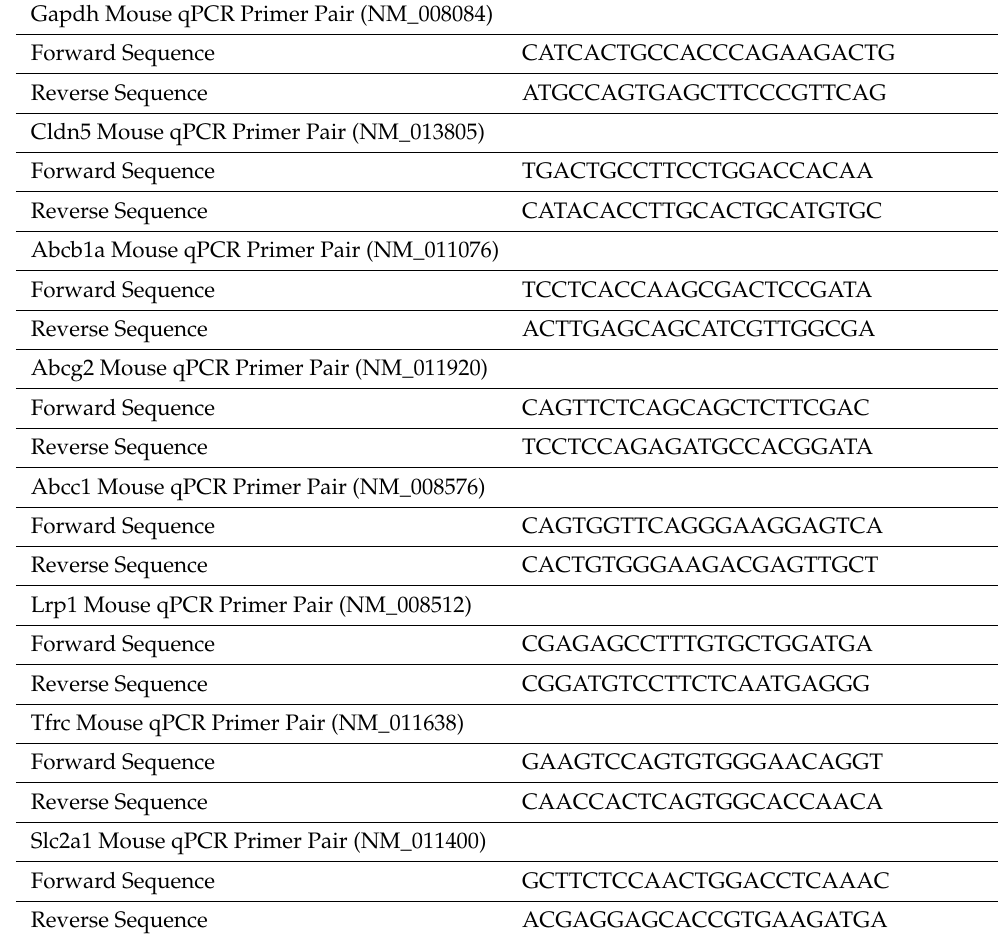
Table 2. List of primers used for the transcriptional profiling of the BBB components through real-time